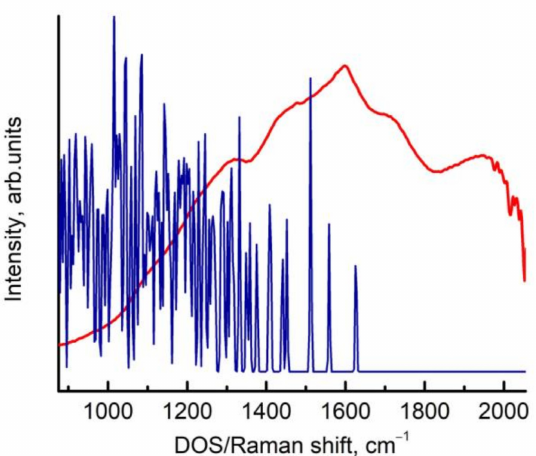
Figure 3. Resonant Raman spectrum and PhDOS of the 2–5 nm